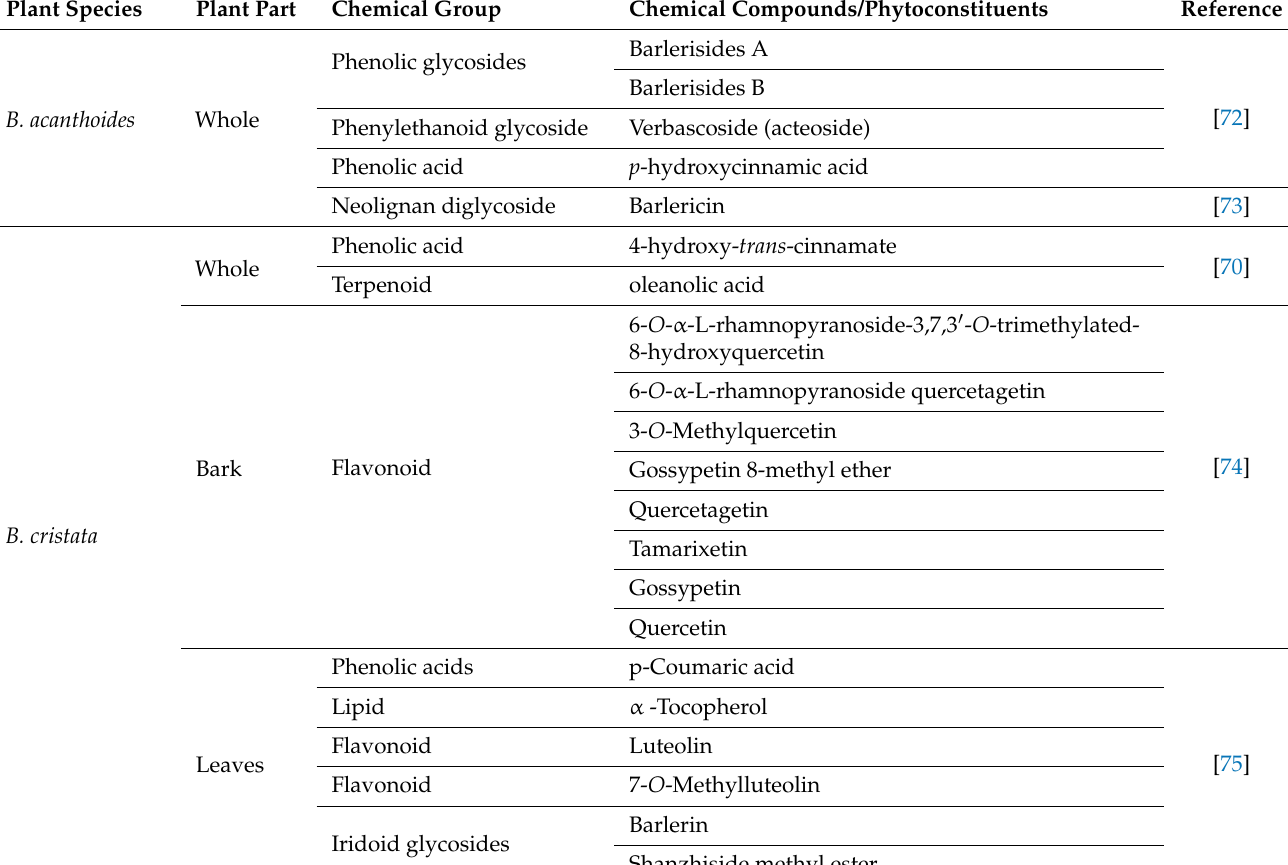
Table 1. Chemical compounds isolated from the Genus Barleria